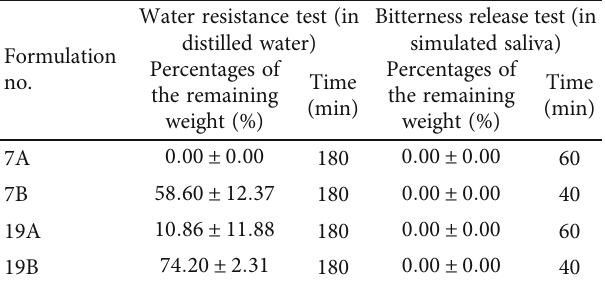
Table 5: Percentages of the remaining weight of lacquer fi lms after testing in distilled water (at 25 ± 1 ° C) and simulated saliva (at 37 ± 1 °